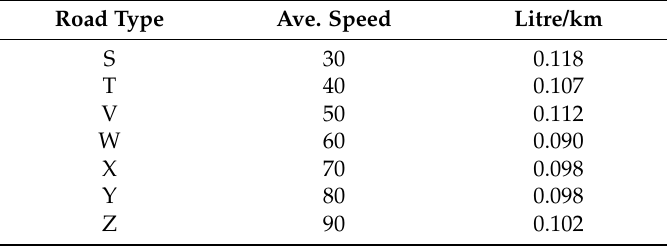
Table 1. The road type and its consumption